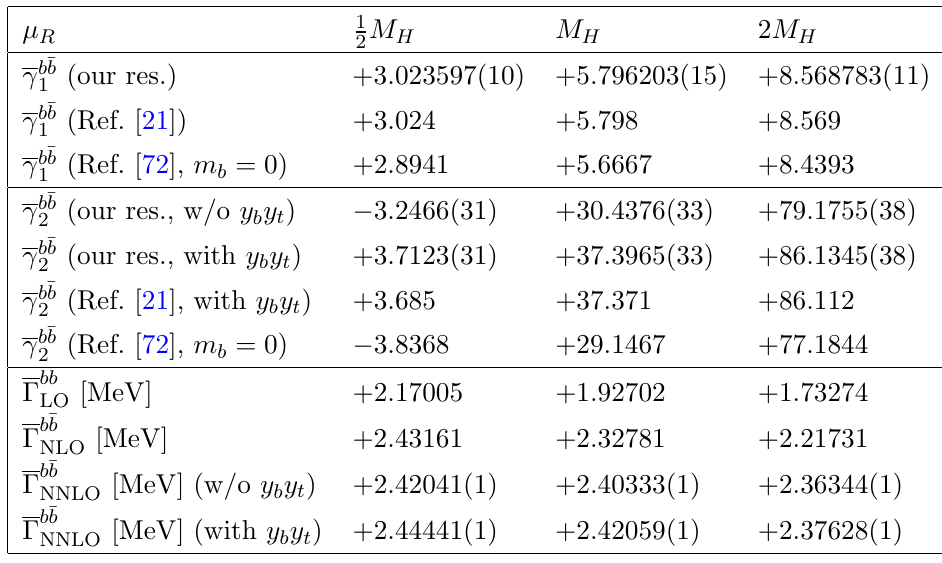
Table 3. The results for the LO, NLO and NNLO total decay width. The total width is calculated using our results for the expansion coe(cid:14)cients, (cid:13) b (cid:22) b ing results from ref. [21]. We also provide results in the limit of massless b -quarks from ref. [72], which do not contain the y b y t contribution. The uncertainties quoted for our results correspond to errors from numerical